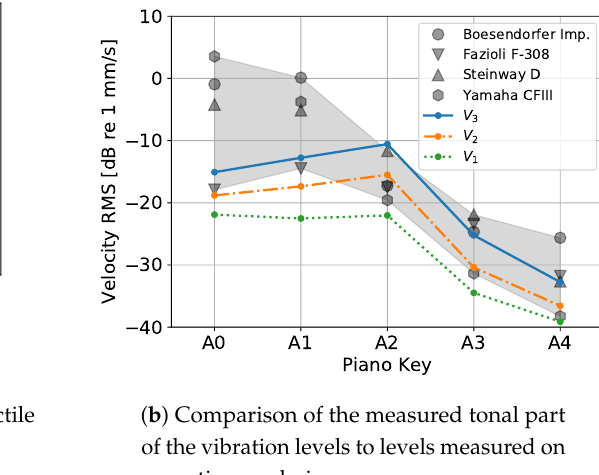
Figure 1. ( a ) Block diagram of the vibrotactile feedback rendering system to generate the key vibrations; the mono audio output of the N3X was filtered and attenuated with a DSP. Thereafter the signal was power amplified to drive the transducer of the built-in vibrotactile rendering system of the N3X. ( b ) Comparison of the tonal part of the vibration levels V 1 , V 2 , V 3 to vibration levels of four acoustic concert grand pianos. The comparison is based on vibrometer measurements of forte keystrokes [7]. ( V 0 is not shown because it corresponds to no